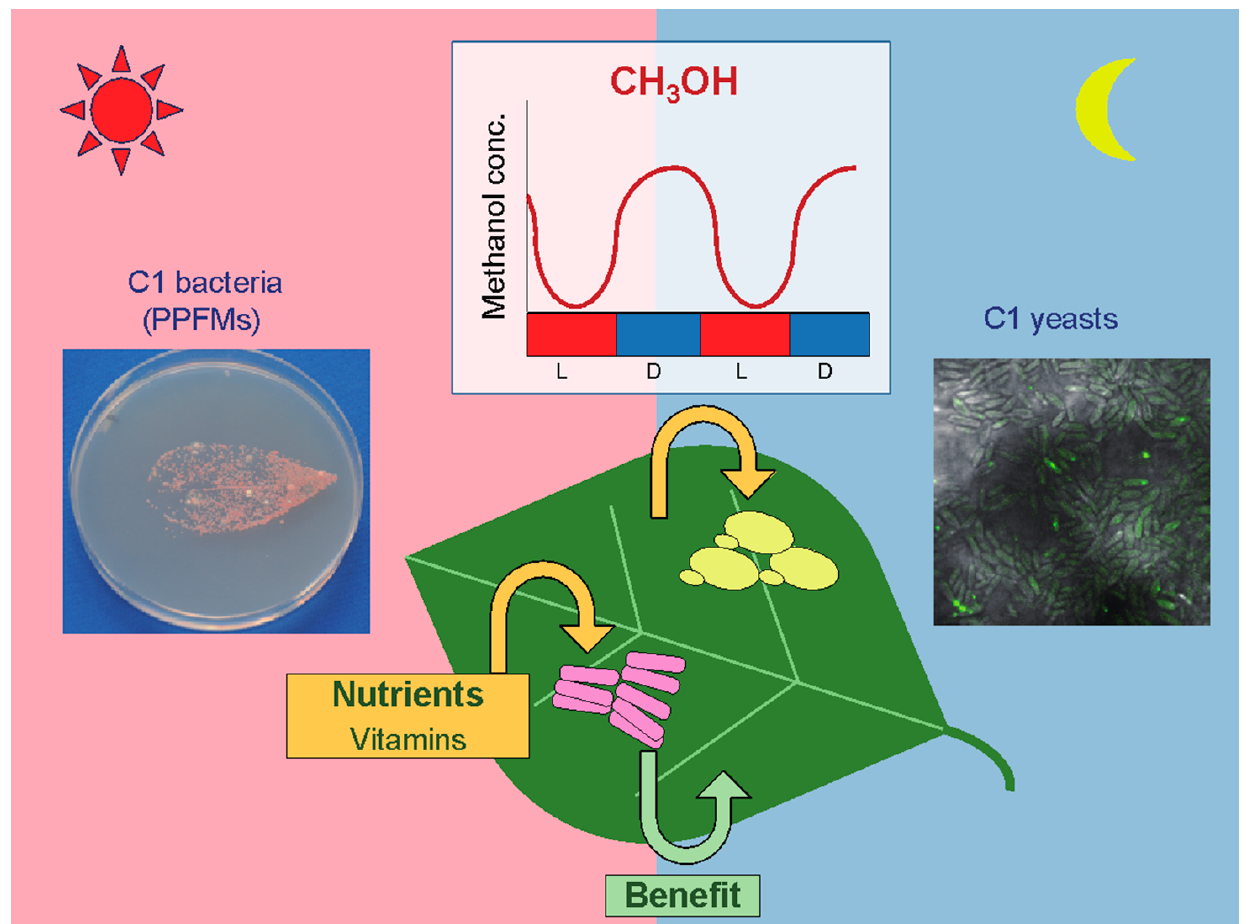
Figure 1. Colonization of methanol-utilizing methylotrophs in the phyllosphere where methanol concentrations oscillate diurnally. Methanol-utilizing bacteria (one-carbon (C1) bacteria, pink-pigmented facultative methylotrophs (PPFMs)) and yeasts (C1 yeasts) colonize the surface of plant leaves and acquire nutrients produced by plants. Concentrations of methanol in the phyllosphere oscillate diurnally, with lower concentrations in the light period (L) and higher concentrations in the dark period (D). After the leaf printing on the agar medium containing methanol as the sole carbon source, pink-pigmented colonies were observed (left panel photo). Candida boidinii cells expressing the fluorescent protein Venus proliferate on Arabidopsis thaliana leaves (right panel photo).